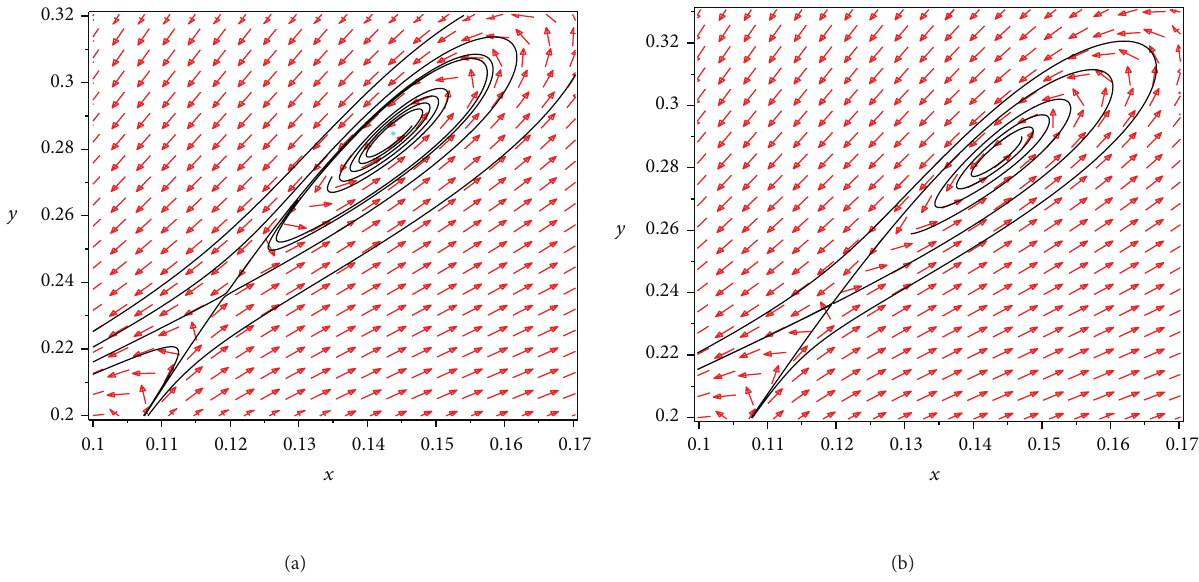
̂𝐸 1 and a hyperbolic saddle